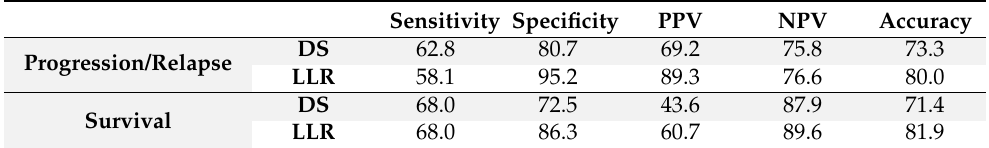
Table 3. The predictive performance of EoT-PET according to DS and LLR.